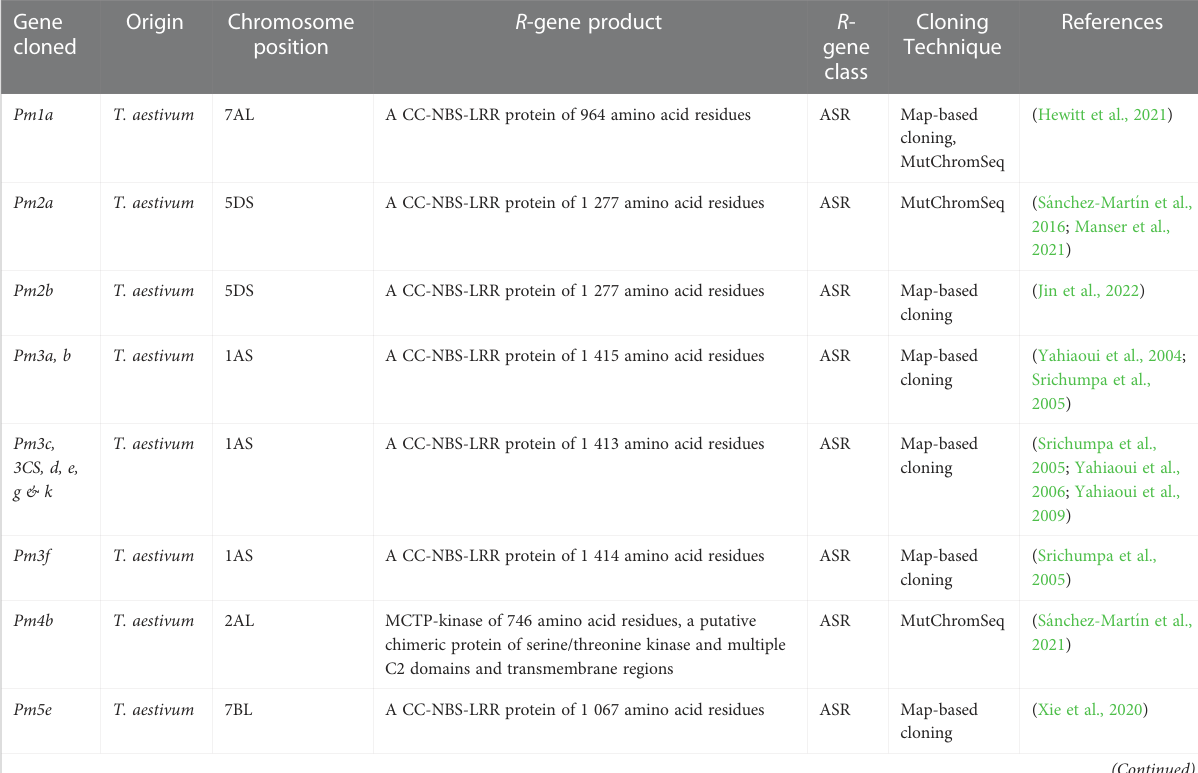
TABLE 1 A summary of cloned wheat powdery mildew resistance